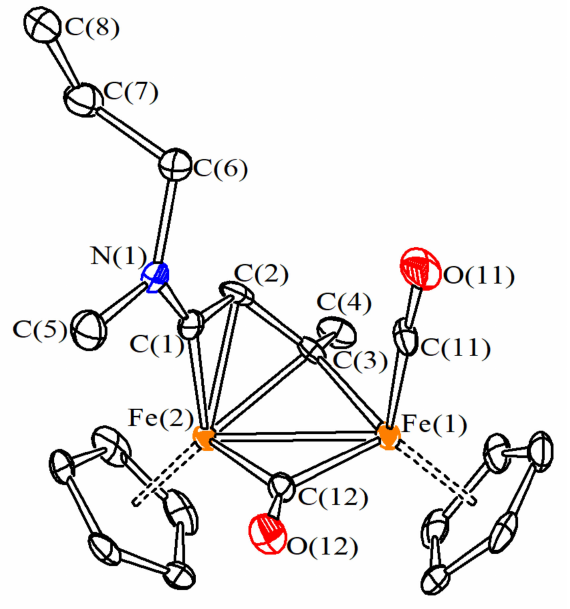
Figure 2. View of the cation of 3a . H atoms have been omitted for clarity. Displacement ellipsoids are at the 50% probability level. Selected bond lengths (Å) and angles ( ◦ ): Fe(1)-Fe(2) 2.5426(7), Fe(1)-C(11) 1.763(3), Fe(1)-C(12) 1.911(4), Fe(2)-C(12) 1.934(4), Fe(2)-C(1) 1.851(3), Fe(2)-C(2) 2.055(3), Fe(2)-C(3) 2.036(4), Fe(1)-C(3) 1.940(4), C(1)-N(1) 1.285(4), C(1)-C(2) 1.419(5), C(2)-C(3)